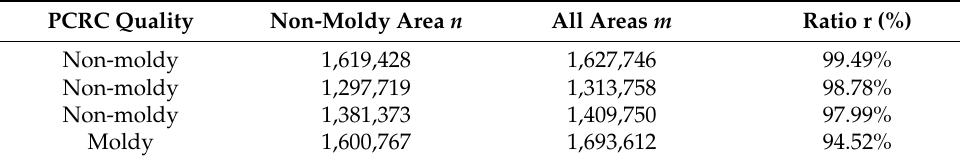
Table 2. Identification ratio.